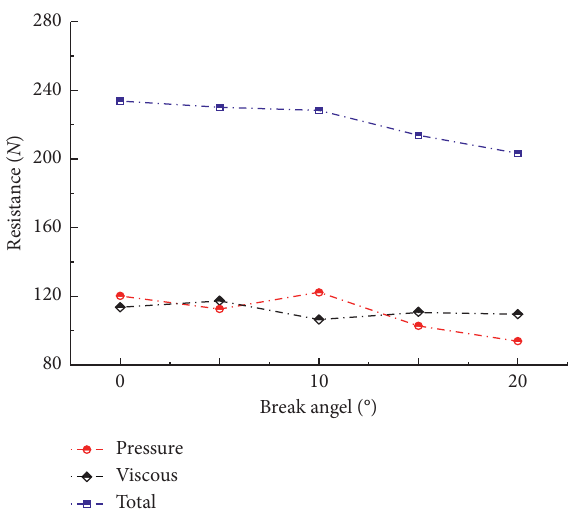
Figure 11: Drag distribution picture.